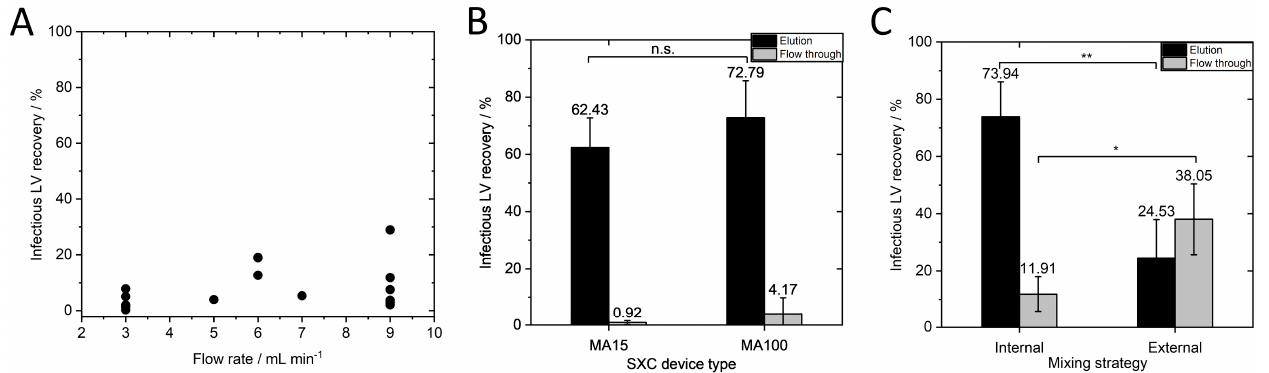
Figure 3. Identification of critical process parameters to achieve a high infectious LV recovery for SXC scale-up. ( A ) Infectious LV recovery for different flow rates between 3 and 9 mL·min − 1 . ( B ) Infectious LV recoveries of MA15 and MA100 with the same surface area-dependent flow rate of 1.43 mL·min − 1 ·cm − 2 (MA15 N = 6, MA100 N = 11). ( C ) Infectious LV recovery for internal and externally mixed LV-PEG-solution, N = 3. Data in B and C represent mean ± standard deviation. p -values are indicated as follows: * p ≤ 0.05, ** p ≤ 0.01, n.s.—not significant.